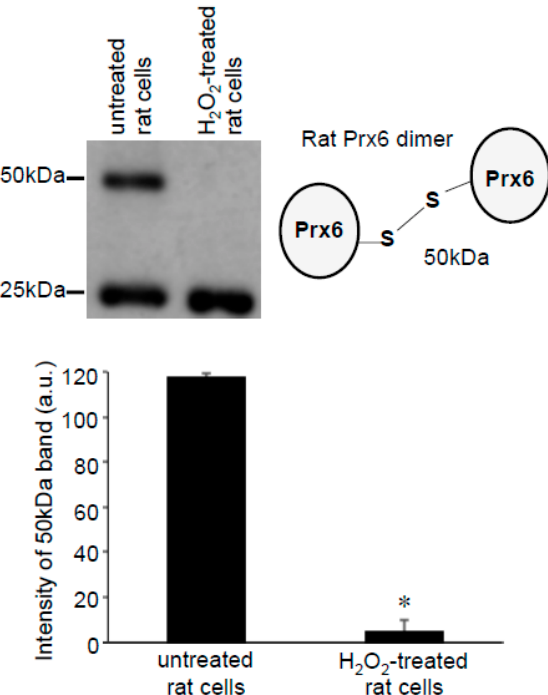
Figure 7. E ff ects of H 2 O 2 on Prx6 dimers in rat cells. Rat pulmonary artery smooth muscle cells were treated with H 2 O 2 (200 µ M) for 15 min. Cell lysates were prepared and subjected to SDS-PAGE and immunoblotting with the Prx6 antibody. No Protein-SHifters were added in these experiments. The bar graph represents the means ± SEM of the intensity of the 50-kDa band ( n = 3). The symbol * represents the value significantly di ff erent from the untreated control value at p < 0.05.